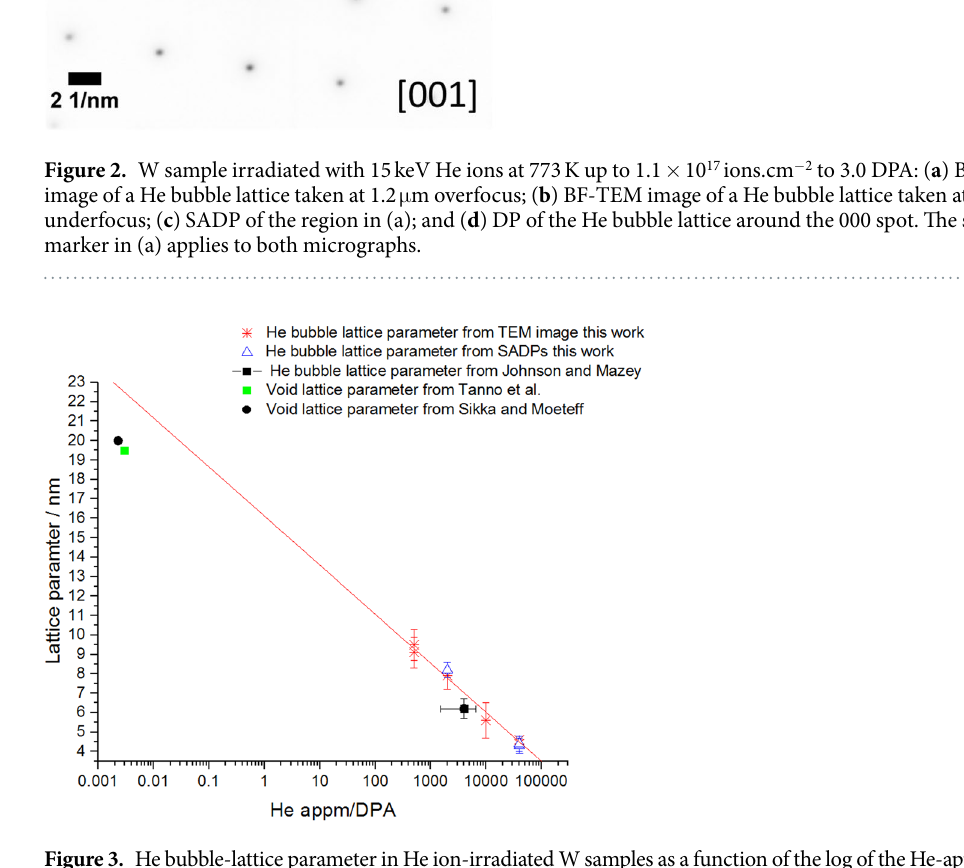
Figure 3. He bubble-lattice parameter in He ion-irradiated W samples as a function of the log of the He-appm/DPA ratio with previous work on He ion irradiation 8 and void-lattice spacings from neutron-irradiated W 12, 13 . (Line of best fit shows linear fit of data reported in this work